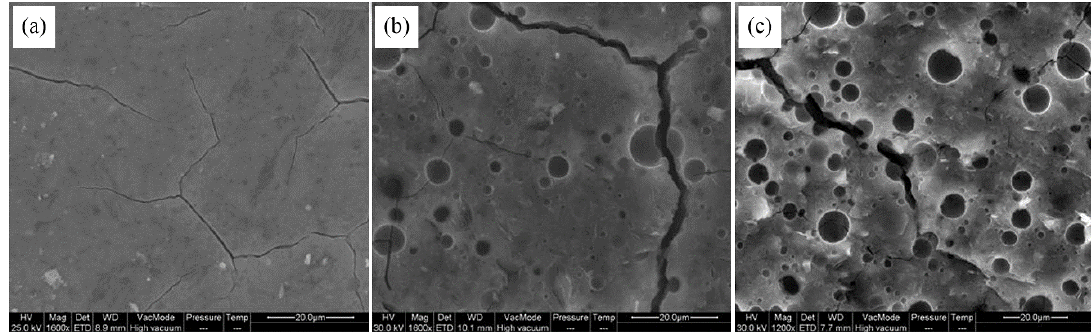
Figure 5. SEM micrographs of (a) GP0, (b) GP3 and (c) GP6 after 28